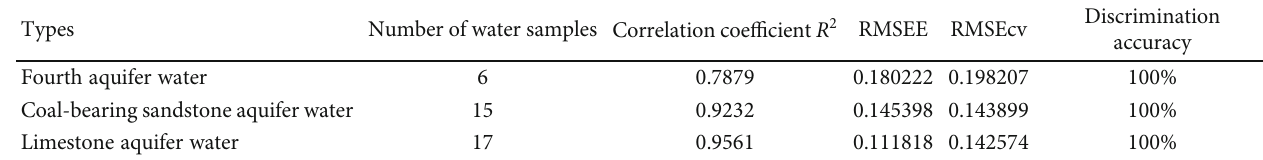
Table 4: Discrimination results of the PLS-DA model of the water sample training set.